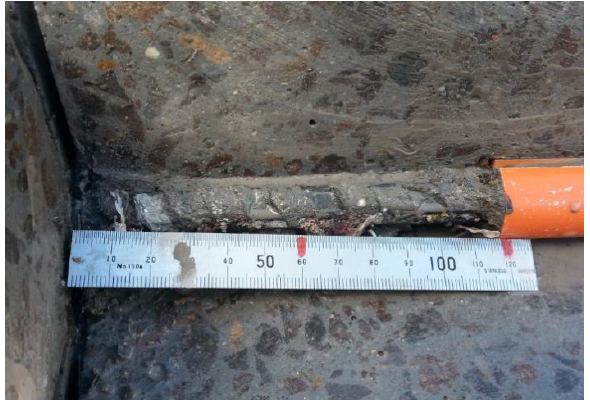
Figure 10. Steel-concrete interface on the GPC beam.